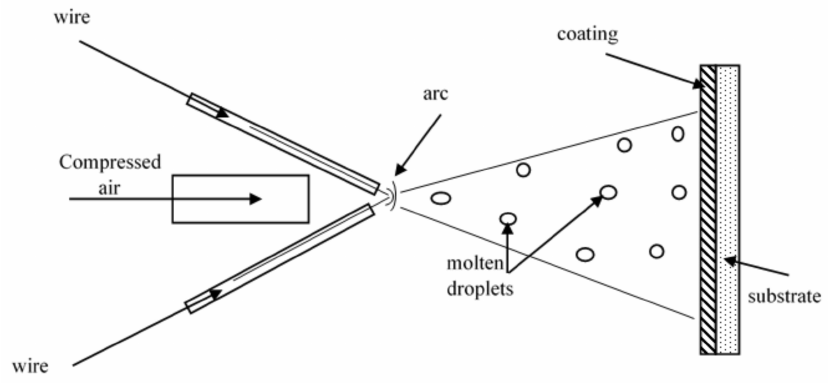
Figure 1. Illustration of the arc-spraying